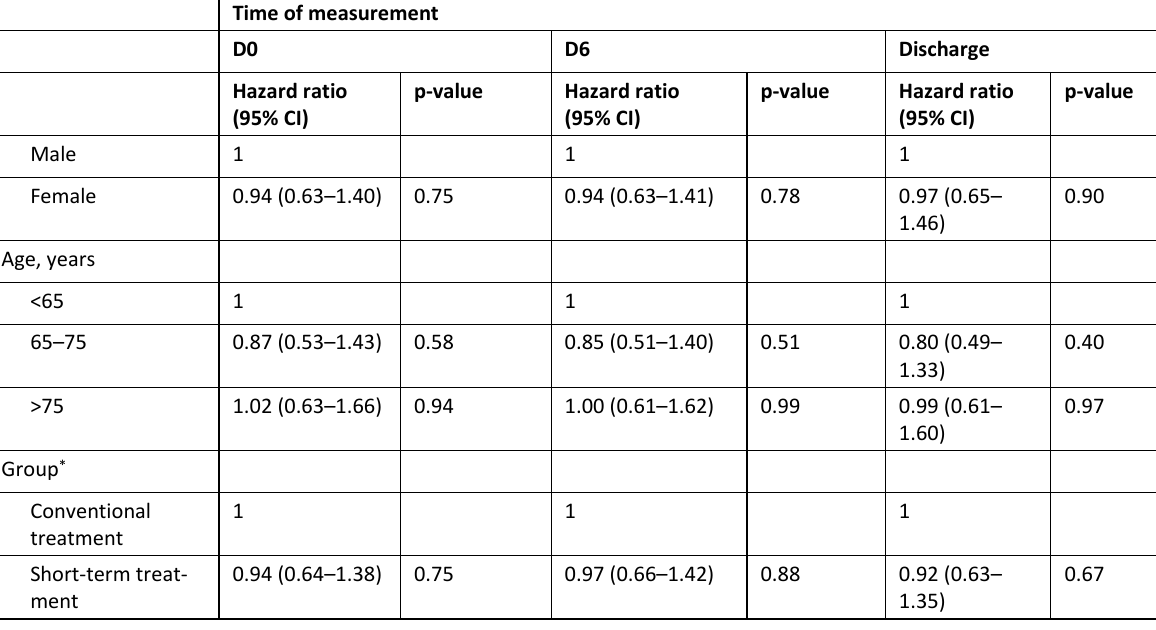
Table 3: Multivariate analyses of predictor variables of time to re-exacerbation. Time of